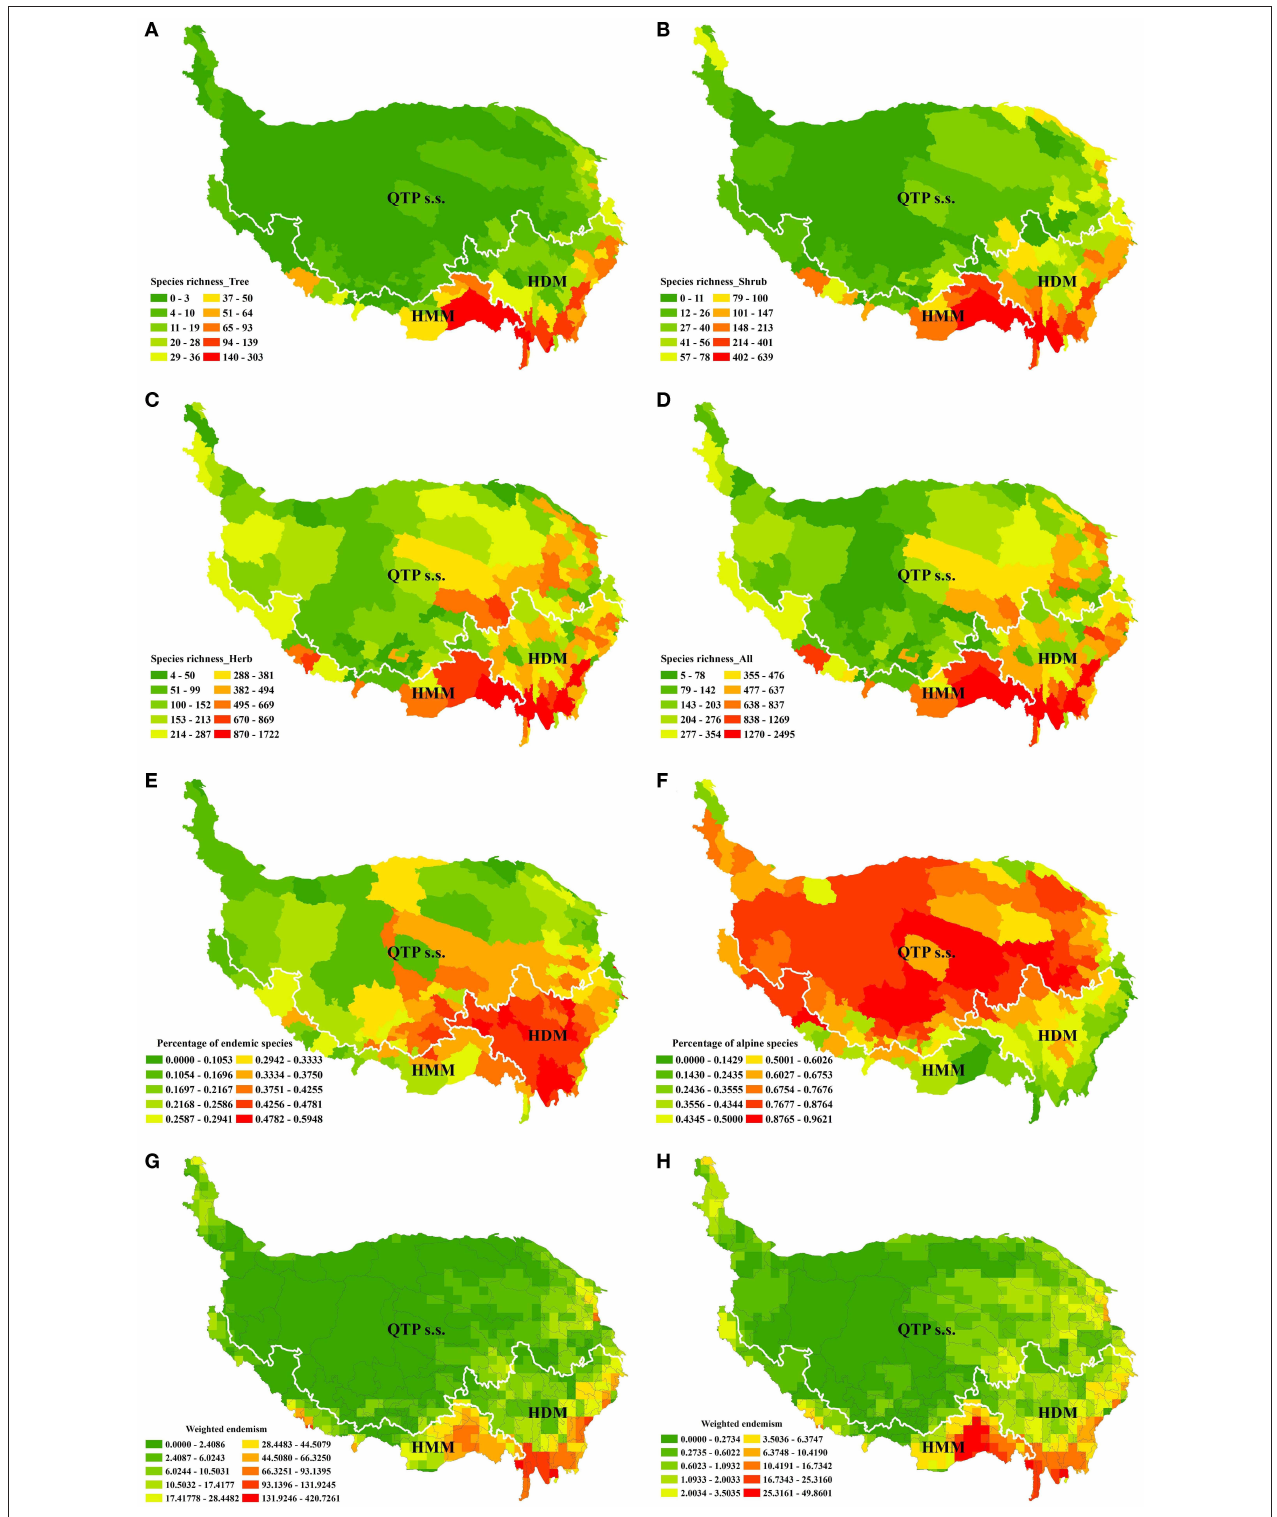
FIGURE 2 | Patterns of floristic diversity in the Qinghai-Tibet Plateau s.l. . (A–D) patterns of species richness for tree, shrub, herbaceous plants, and all species. (E) pattern of ratio of endemic species in a county. (F) pattern of ratio of alpine species in a county. (G,H) patterns of weighted endemism at the species and genus levels. HDM, the Hengduan Mountains; HMM, the Himalayas; QTP s.s. , the Qinghai-Tibet Plateau sensu stricto. White lines represent the boundary between the Hengduan Mountains, the Himalayas and the QTP s.s. .